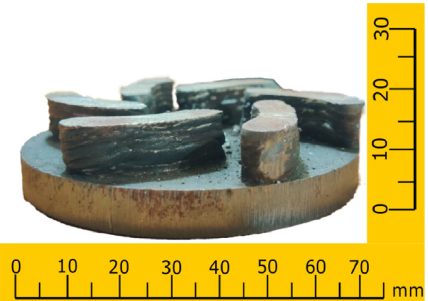
Figure 25: Near-net shape of the impeller realized through embedded substrate method.